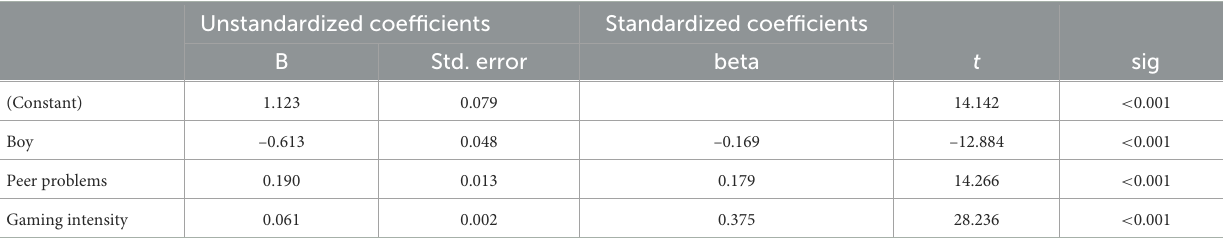
TABLE 4 Regression analysis in the HBSC sample for peer problems on reported IGD symptoms, controlled for gaming intensity and sex.